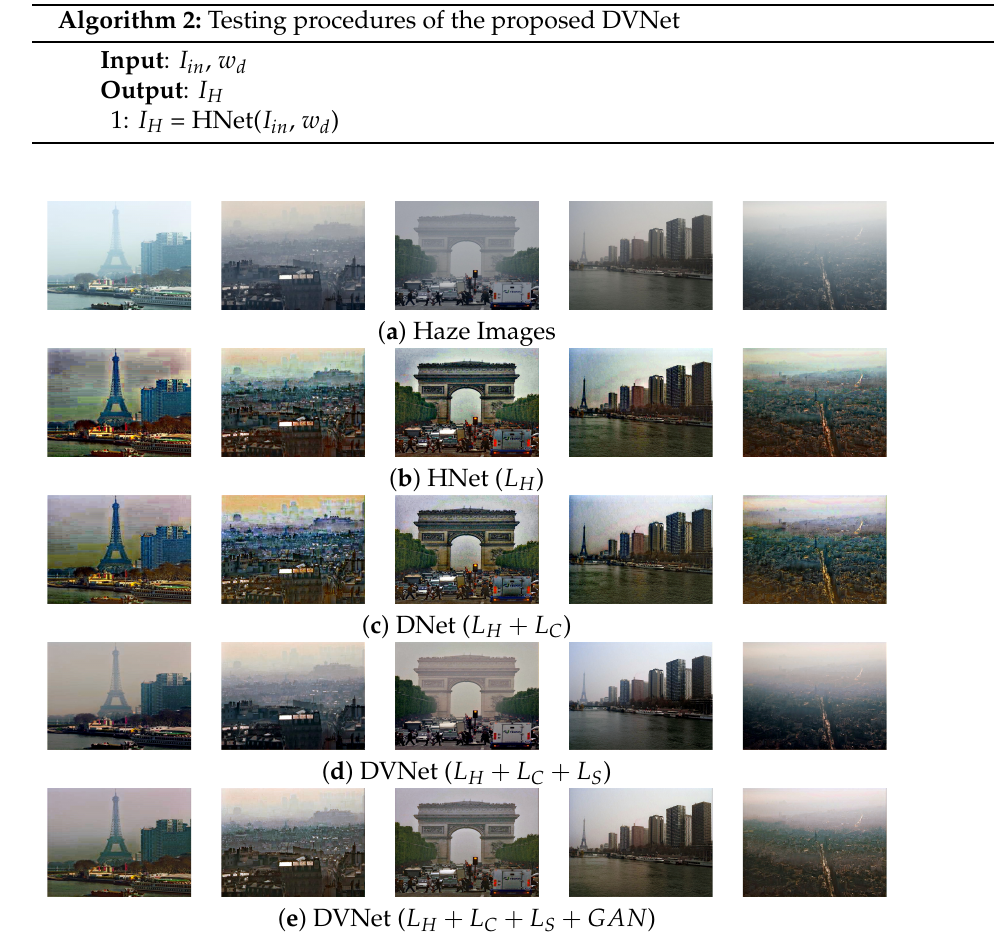
Algorithm 2: Testing procedures of the proposed DVNet